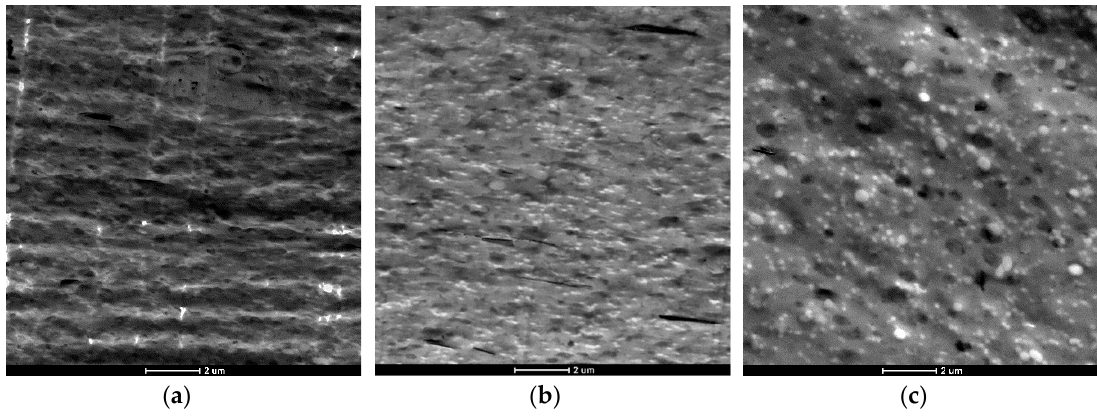
Figure 6. TEM micrographs of POST-I blend with different amount of MDI: ( a ) 2%; ( b ) 3%; ( c ) 5%.